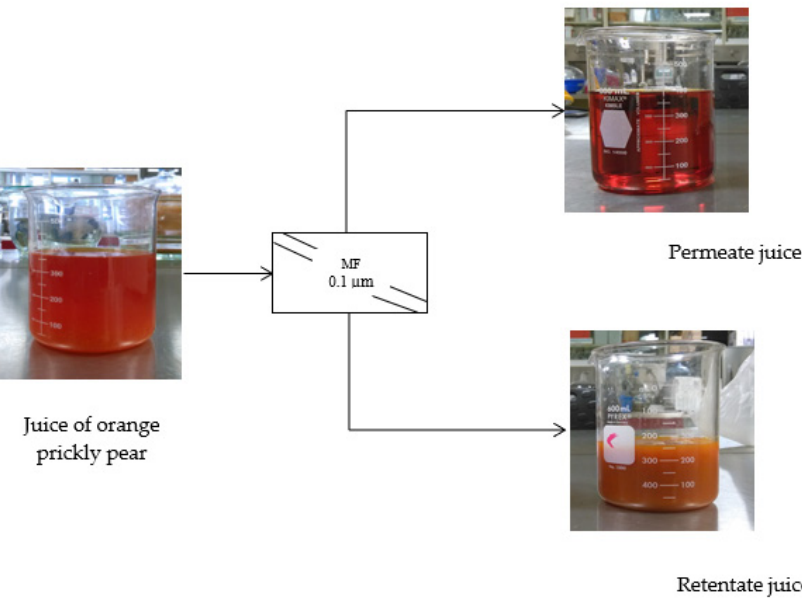
Figure 5. Schematic representation of the microfiltration process of the orange prickly pear juice